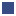
Influence of increasing concentrations of alginate on zeta potential (■) and size (■) of bare (A), amine-functionalised (B), carboxylate-functionalised (C) and aromatic-functionalised (D) silica NPs.